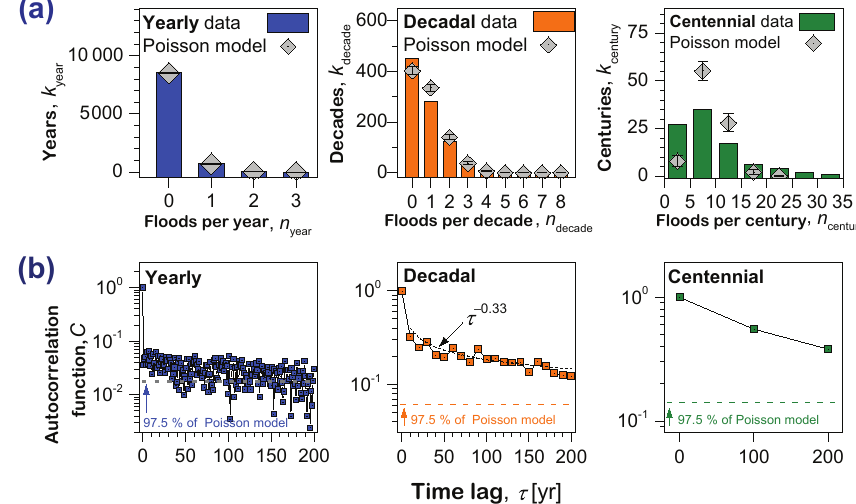
Figure 6. Histograms and autocorrelation of the palaeoflood time series with the corresponding Poisson model. (a) Histogram (also shown in Fig. 3) of the number of floods per year (blue bars), decade (orange bars), and century (green bars), with each compared to the Poisson model with respective rate parameters λ year = 0 . 083 floods yr − 1 , λ decade = 0 . 83 floods decade − 1 , and λ century = 8 . 3 floods century − 1 . Diamonds represent the mean Poisson model value and the error bars the standard deviation over 100 realizations. (b) Autocorrelation function (ACF) (Eq. 5) of the number of floods per year (blue squares), decade (orange squares), and century (green squares). Also shown for the ACF of the number of floods per decade is the best-fitting power-law model to the ACF (black dotted line) (Eq. 13). Also shown are the 97.5th percentile, i.e. the upper bound of the 95% confidence interval of the ACF (for lags τ> 0) of an uncorrelated signal with the same one-point probability distribution (i.e. realization of a Poisson model).